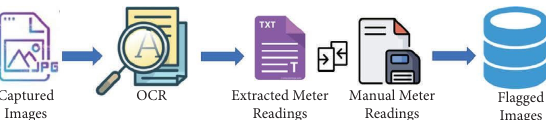
Figure 4: New system design.